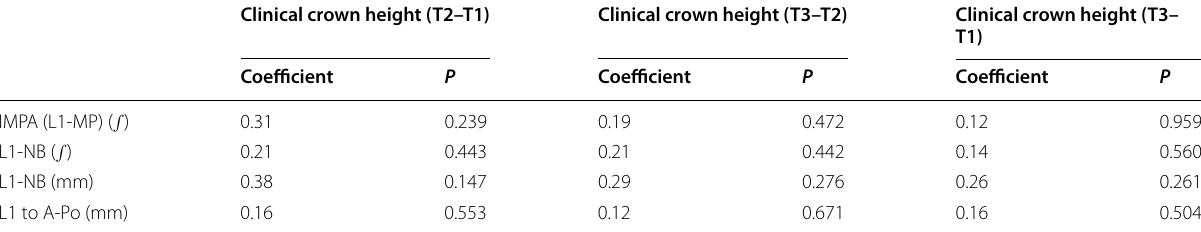
T1—Pretreatment; T2—Posttreatment; T3—Follow-up